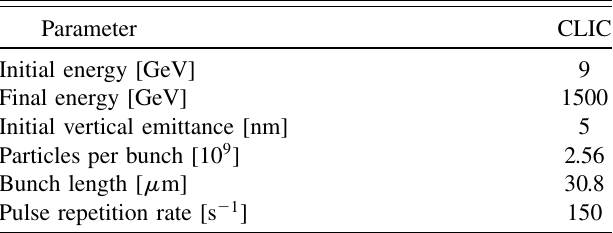
TABLE I. CLIC beam